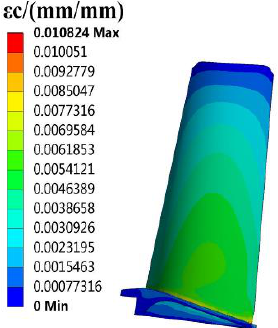
Figure 7. Distribution of blade creep strain.